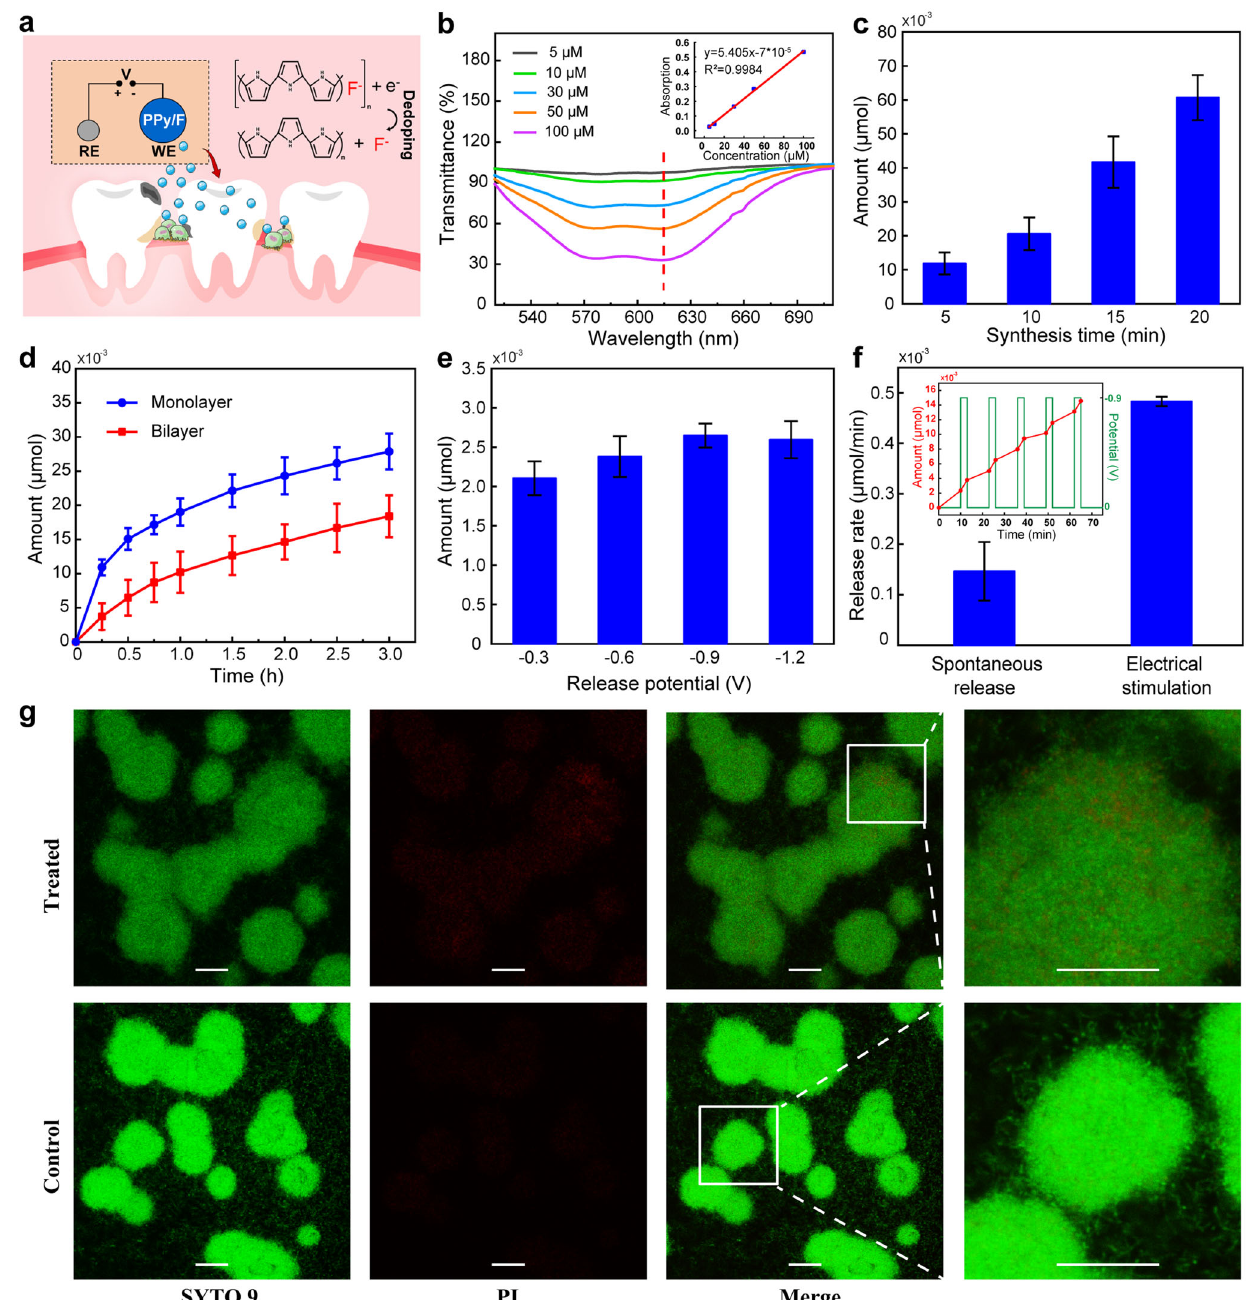
Fig. 5 Evaluation of the electrically controlled fl uorides delivery. a Schematic of electrically controlled release of fl uorides from the drug delivery module. Once the treatment command was given, the fl uorides could be released locally on the tooth surface by the negative potential applied to the electrodes. b Transmission spectra of the fl uoride complex with the fl uorides varying from 5 to 100 μ M. The inset was the calibration curve between the absorbance of the fl uoride complex at 614 nm and the concentration of the fl uorides. c In fl uence of synthesis time on the amount of fl uorides loaded on the electrodes. d Amount of fl uorides released spontaneously from different electrodes, including monolayer-electrode (modi fi ed with only PPy/F) and bilayer-electrode (modi fi ed with both PPy/PSS and PPy/F). e Effect of release potential on the amount of fl uorides released from the electrodes. f Release rate comparison between the spontaneous release and the electrical stimulation. The release rate was de fi ned as the amounts of fl uorides released per minute from the drug delivery electrode under the spontaneous release or under the electrical stimulation. The inset was the real-time release amounts of the fl uorides under the alternating action of the spontaneous release and the electrical stimulation (red). The electrical stimulation was a constant potential of − 0.9 V (green). g Confocal laser scanning microscopy (CLSM) images of S. mutans samples stained by the bacterial viability kit for evaluation of the antibacterial activity of the drug delivery module. The bacteria with an intact cell membrane were stained green by the SYTO 9 nucleic acid stain, while the dead or dying bacteria with a damaged membrane were stained red by the propidium iodide (PI) nucleic acid stain. The merge referred to the overlap of two fl uorescent images. Scale bars, 20 μ m. Error bars indicated standard